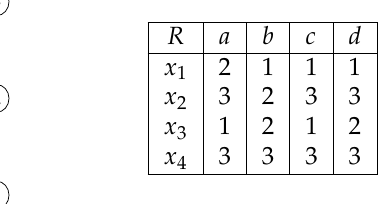
Figure 1. Complete lattice L ( left ) and one-sided formal context ( right ) of Example